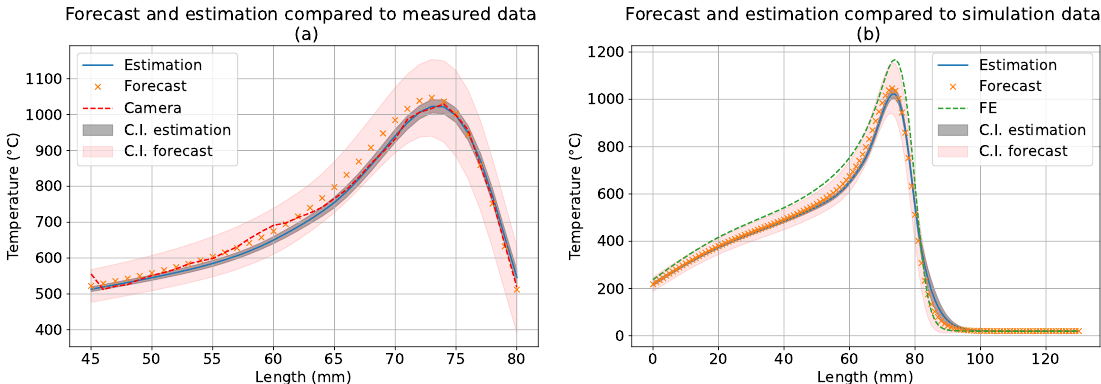
Figure A2. Forecasted temperature conditioning by the known and unknown parameters ( µ , θ ) and posterior estimation using the infrared camera data with their correspondent confidence interval. ( a ) Compared to experimental camera data. ( b ) Compared to FE